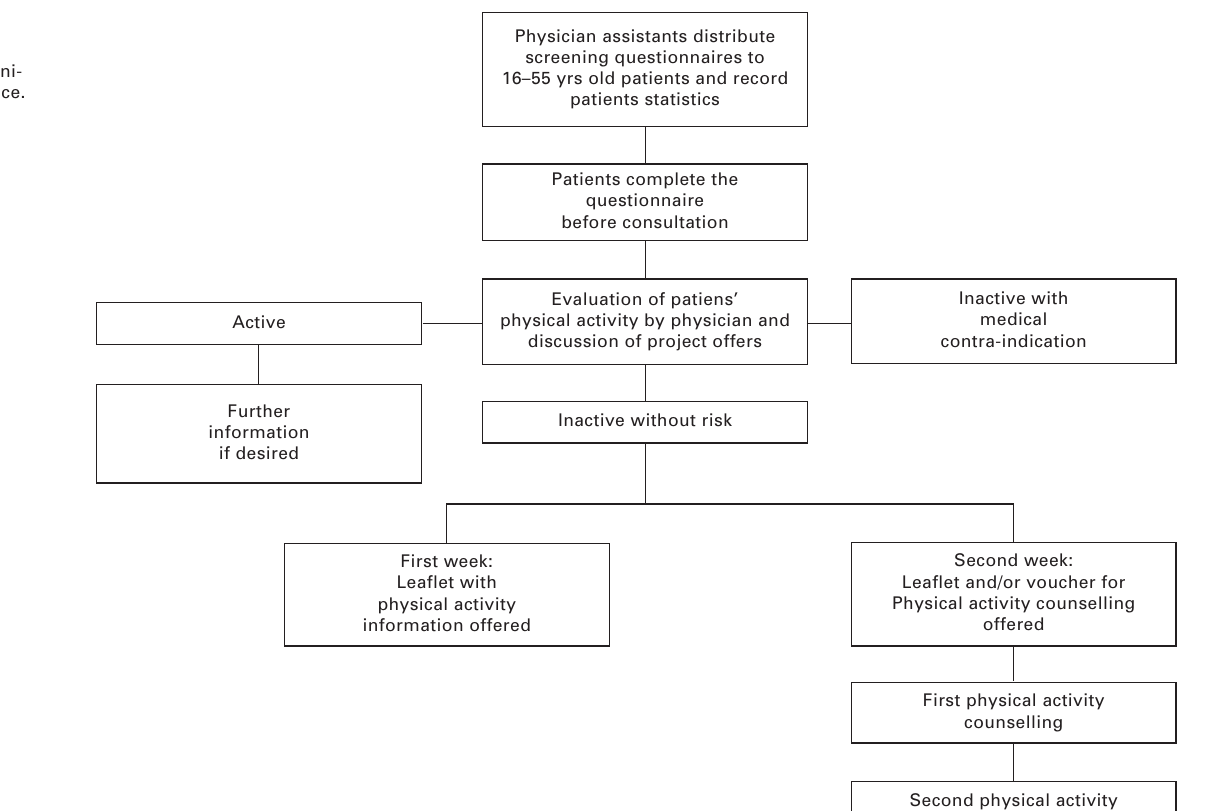
Flow chart of project organi- sation in